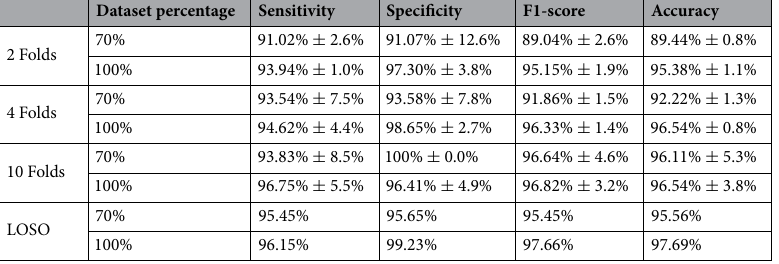
Table 2. The classification accuracy of the proposed BNN-based system at different sizes of the dataset.